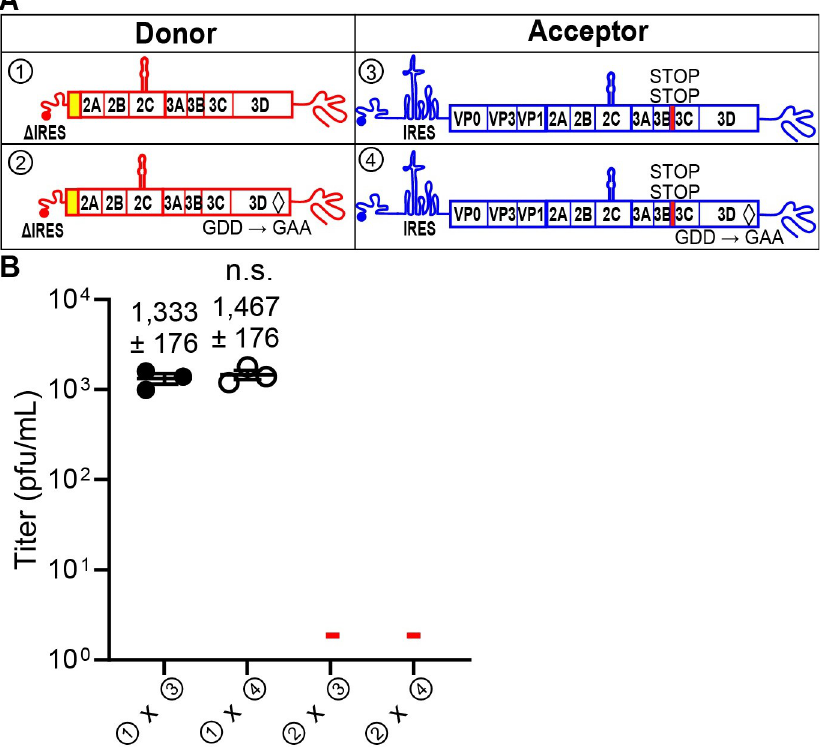
Fig 3. RNA virus recombinants are consistent with the donor RNA as the source of the PV RdRp, 3Dpol, and not the acceptor RNA. (A) A mutation (GDD to GAA) producing an inactive PV RdRp, shown by a black diamond ( ^ ), was introduced into either the donor or acceptor RNAs ( ② and ④ ). Insertion of two STOP codons (UAGUAA) after the 3B-coding sequence (3B STOP), indicated by a red rectangle, was introduced into the acceptor RNAs ( ③ and ④ ). (B) The indicated donor and acceptor RNAs were cotransfected into L929 cells. Yields of recombinant virus following transfection are shown (pfu/mL ± SEM; n = 3 ).—indicates that plaques were not detected (limit of detection: 2